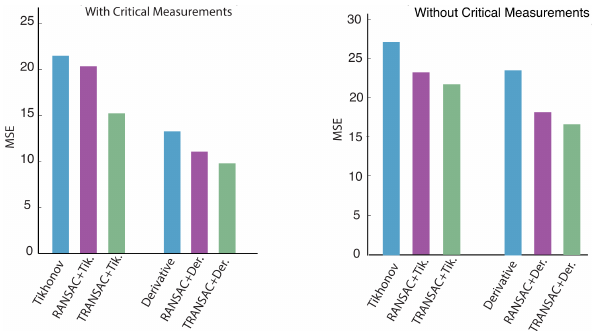
Figure 9. MSE of source estimated by different algorithms. The blue bars correspond with the original algorithms (Eqs. 2, 3). The violet bars indicate that RANSAC is used for outlier removal, and the green ones shows that TRANSAC is used for outlier removal. The plot on the left was generated using the whole ETEX data set. The plot on the right was generated using the ETEX data set without critical